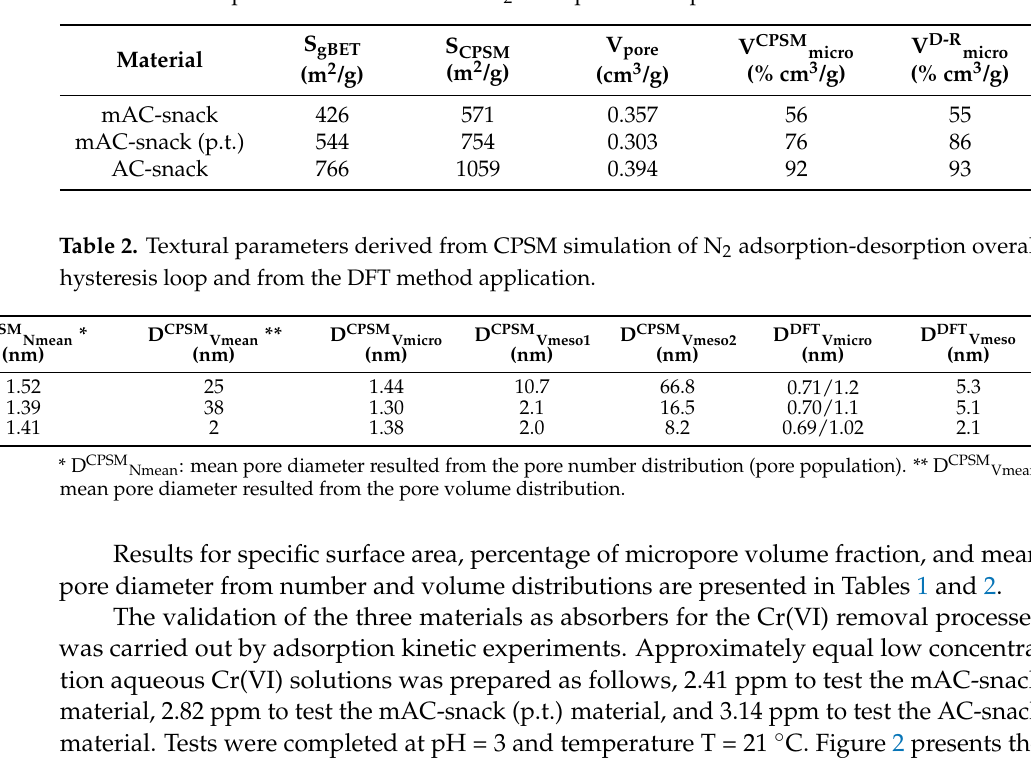
Table 1. Textural parameters derived from N 2 adsorption-desorption measurements.